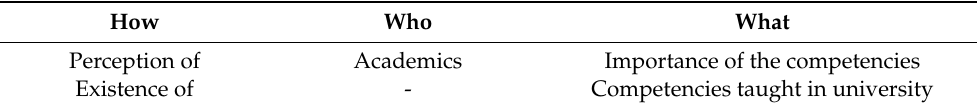
Table 5. Example of the competencies analysis carried out in each